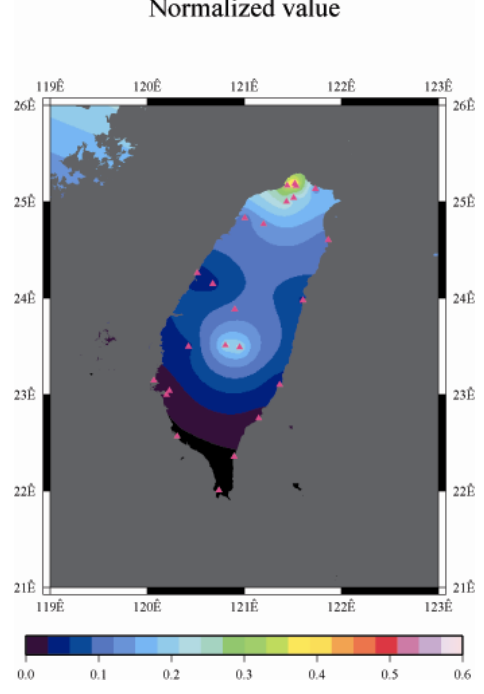
Figure 14. Normalized rainfall values around the island when the typhoon started to strike Taiwan (September 13th, 2008, 11:00